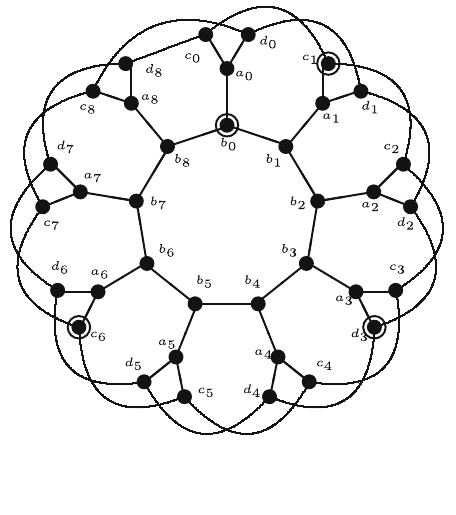
Figure 1: Graph J 9